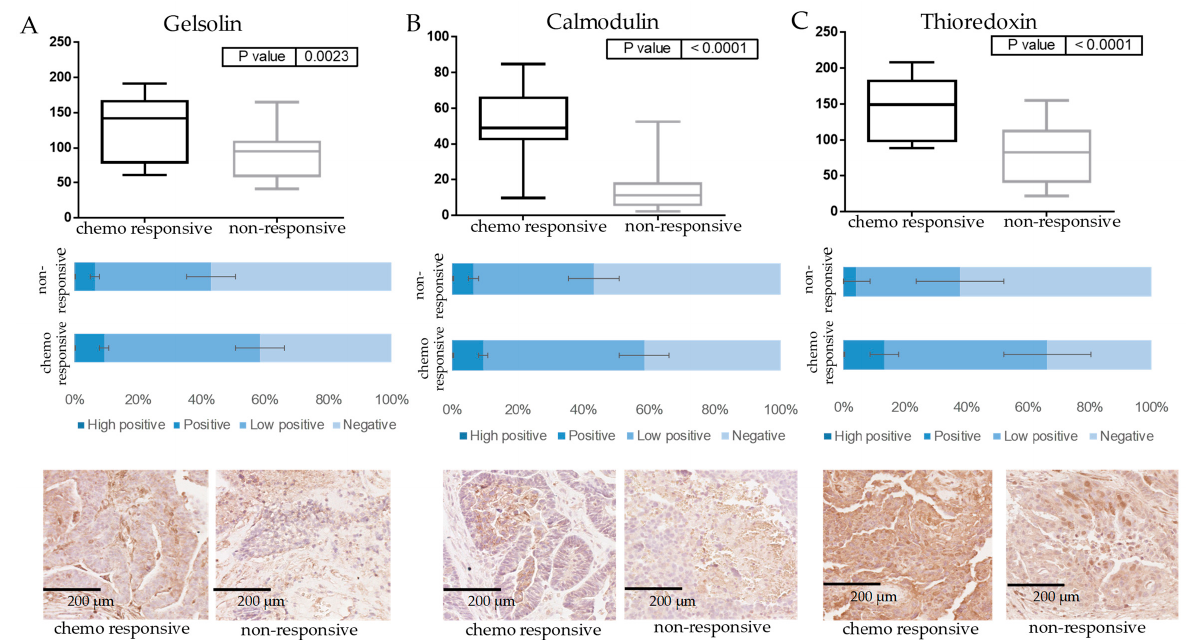
Figure 2. Immunohistochemical staining of gelsolin, calmodulin, and thioredoxin. IHC staining comparing ovarian tumors from patients who did not respond (n = 8) to chemotherapy to those who did (n = 21) for gelsolin, p value = 0.0023 ( A ), calmodulin, p value < 0.0001 ( B ), and thioredoxin, p value < 0.0001 ( C ). The graphs show the level of high-positive, positive, low-positive, and negative staining for the chemo-responsive patients compared to the non-responsive patient cohort. Representative image of stained tissue at 20× magni fi cation from the responsive and non-responsive patients is shown at the bo tt om of each graph. The level of positive staining across the patients was summed and signi fi cance was calculated using un-paired t -test using GraphPad prism. Quantitative analysis was per- formed using IHC pro fi ler-Image J. For each tissue section, three representative photo-micrographic images at 40× magni fi cation were used..